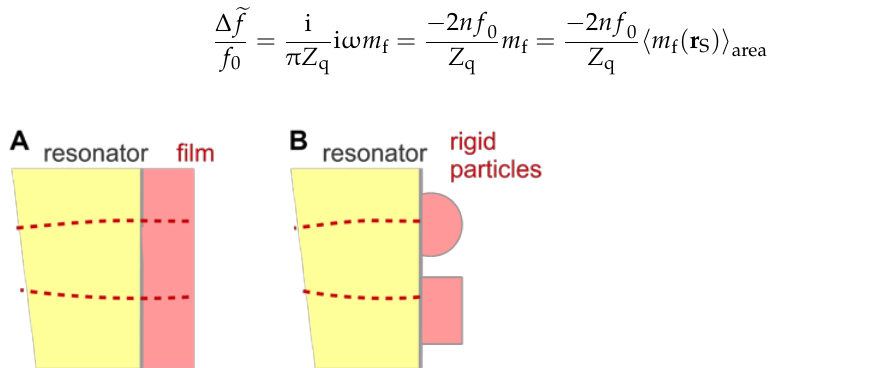
Figure 11. The Sauerbrey equation applies to thin rigid films ( A ) and other rigid samples ( B ). In the latter case, the mass per unit area must be area-averaged.